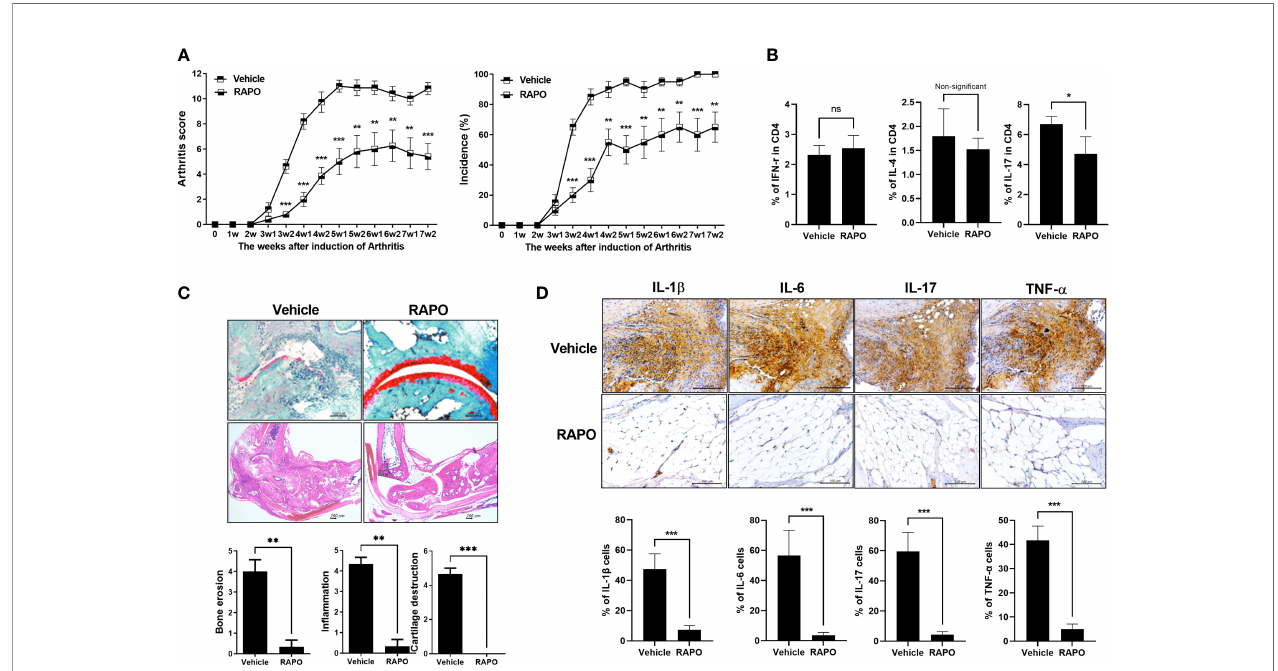
FIGURE 5 | Effects of Bi fi dobacterium longum RAPO in obese CIA mice. Mice were administered orally with B. longum RAPO (1 × 10 8 CFU/mouse) once daily for 7 weeks after the immunization boost. (A) Arthritis score and incidence of B. longum RAPO-treated mice compared with those of obese CIA mice ( n = 5 for each group). (B) B. longum RAPO reduces IL-17 expression in CD4 T cells from the spleen of mice with obese CIA. Flow cytometry of Th1 cells (IFN-r + CD4 + ), Th2 cells (IL-4 + CD4 + ), and Th17 cells (CD4 + IL17 + ) from the spleen of mice with obese CIA. (C) Effect of B. longum RAPO on RA in mice with obese CIA. Tissue from the hind paw joints was stained with hematoxylin and eosin, as well as safranin O. (D) B. longum RAPO inhibits the proin fl ammatory cytokines IL-1 b , IL-6, IL-17, and TNF a in CIA mice. Representative immunohistochemistry images showing that B. longum RAPO alleviates RA in obese CIA mice. Synovium sections treated with a vehicle, B. longum RAPO, or vehicle were stained for IL-1 b , IL-6, IL-17, and TNF a . Scale bar, 100 m m. * p < 0.05; ** p < 0.01; *** p < 0.001 ( vs . vehicle-treated